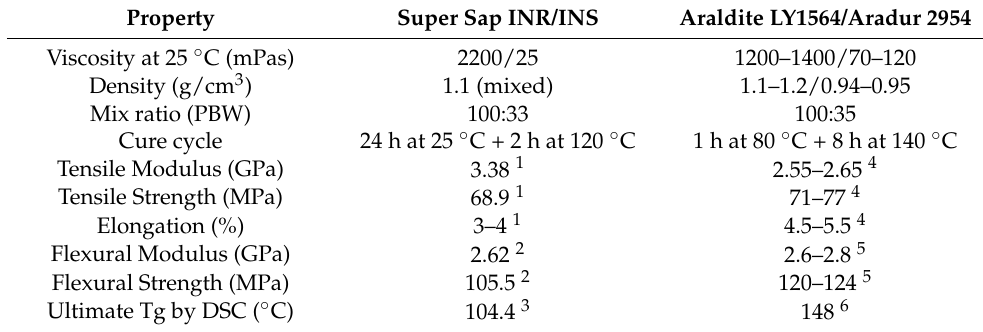
Table 2. Applied adhesives properties